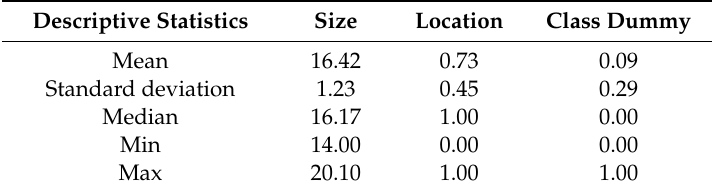
Table 8. Explanatory variables: Descriptive